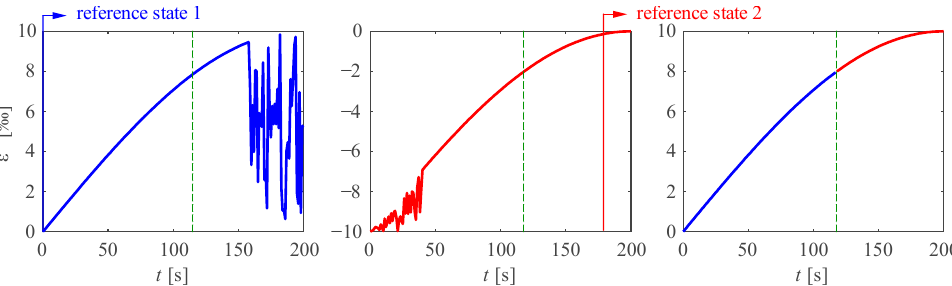
Figure 4. Restoring noisy data with a spectrometer maintaining the same virtual gauges in all reference states and a measurement correlation in the post-processing.